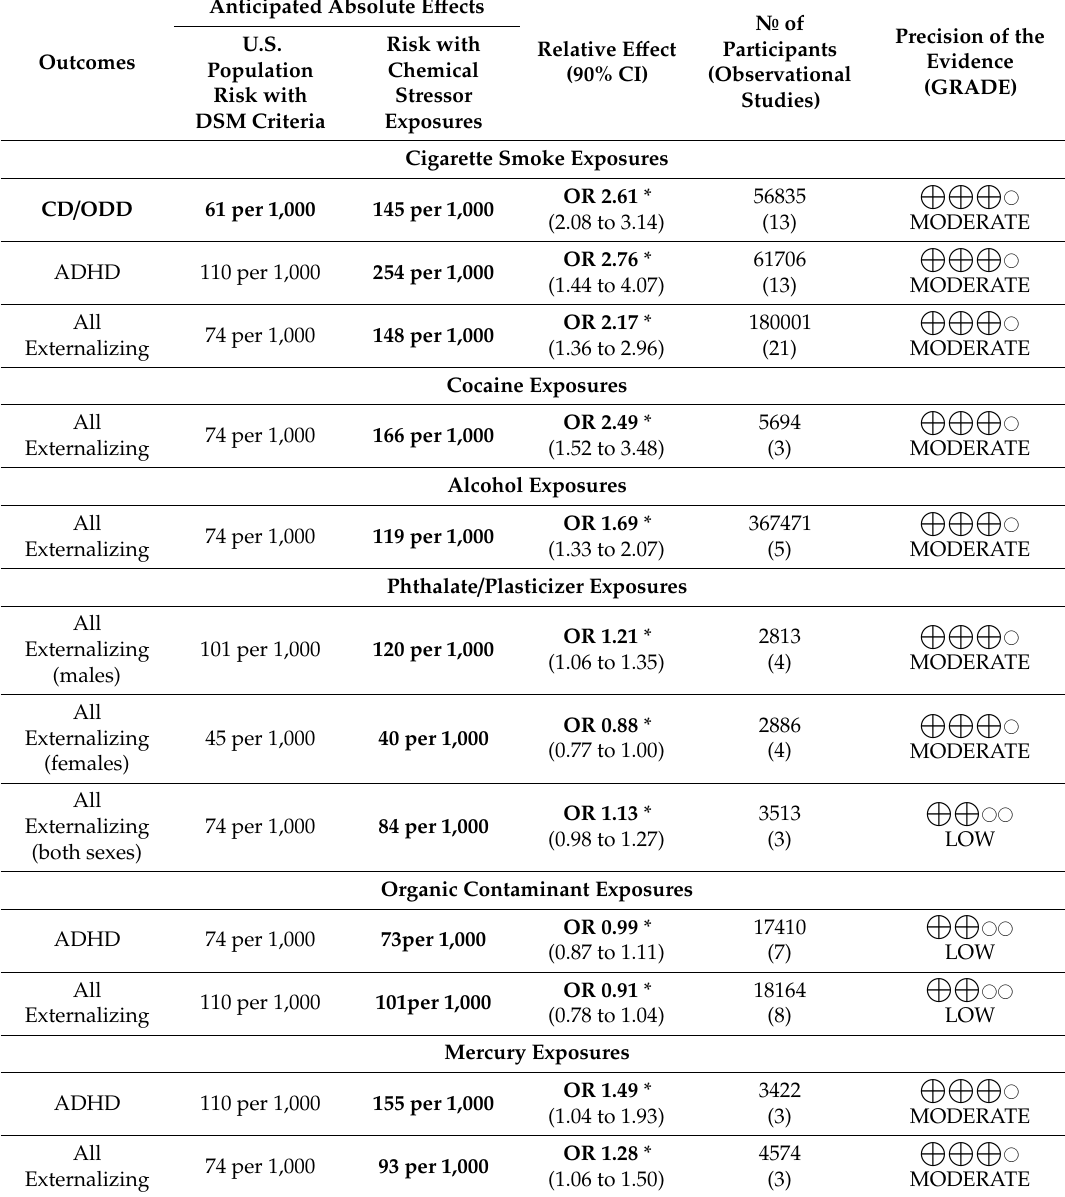
Table 1. Summary of findings from the systematic review of prenatal exposures to chemical stressors related to childhood externalizing behaviors. Table was modified from the GRADEpro GDT